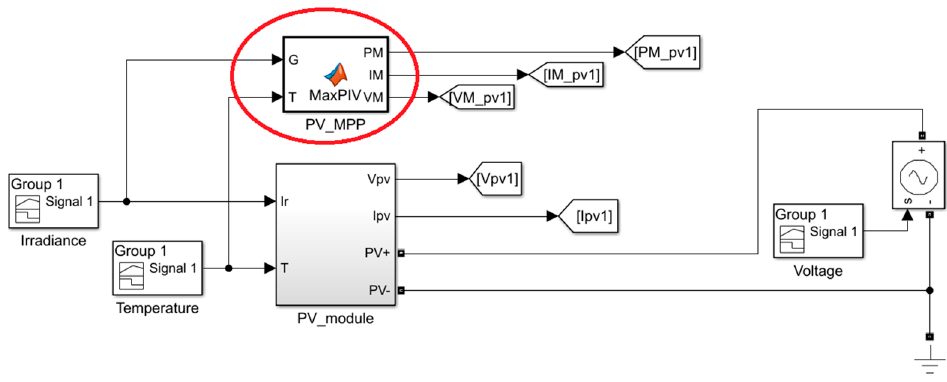
Figure 4. PV testing of the optimisation algorithm without controlling the power. The varying test conditions are presented in Figure 5.